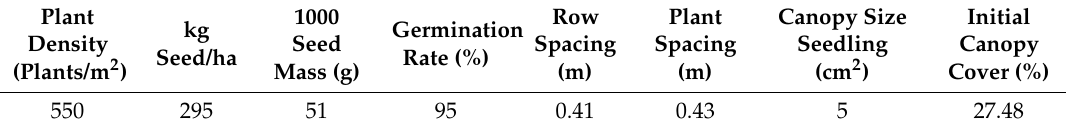
Table 4. The crop input data that derived from the field